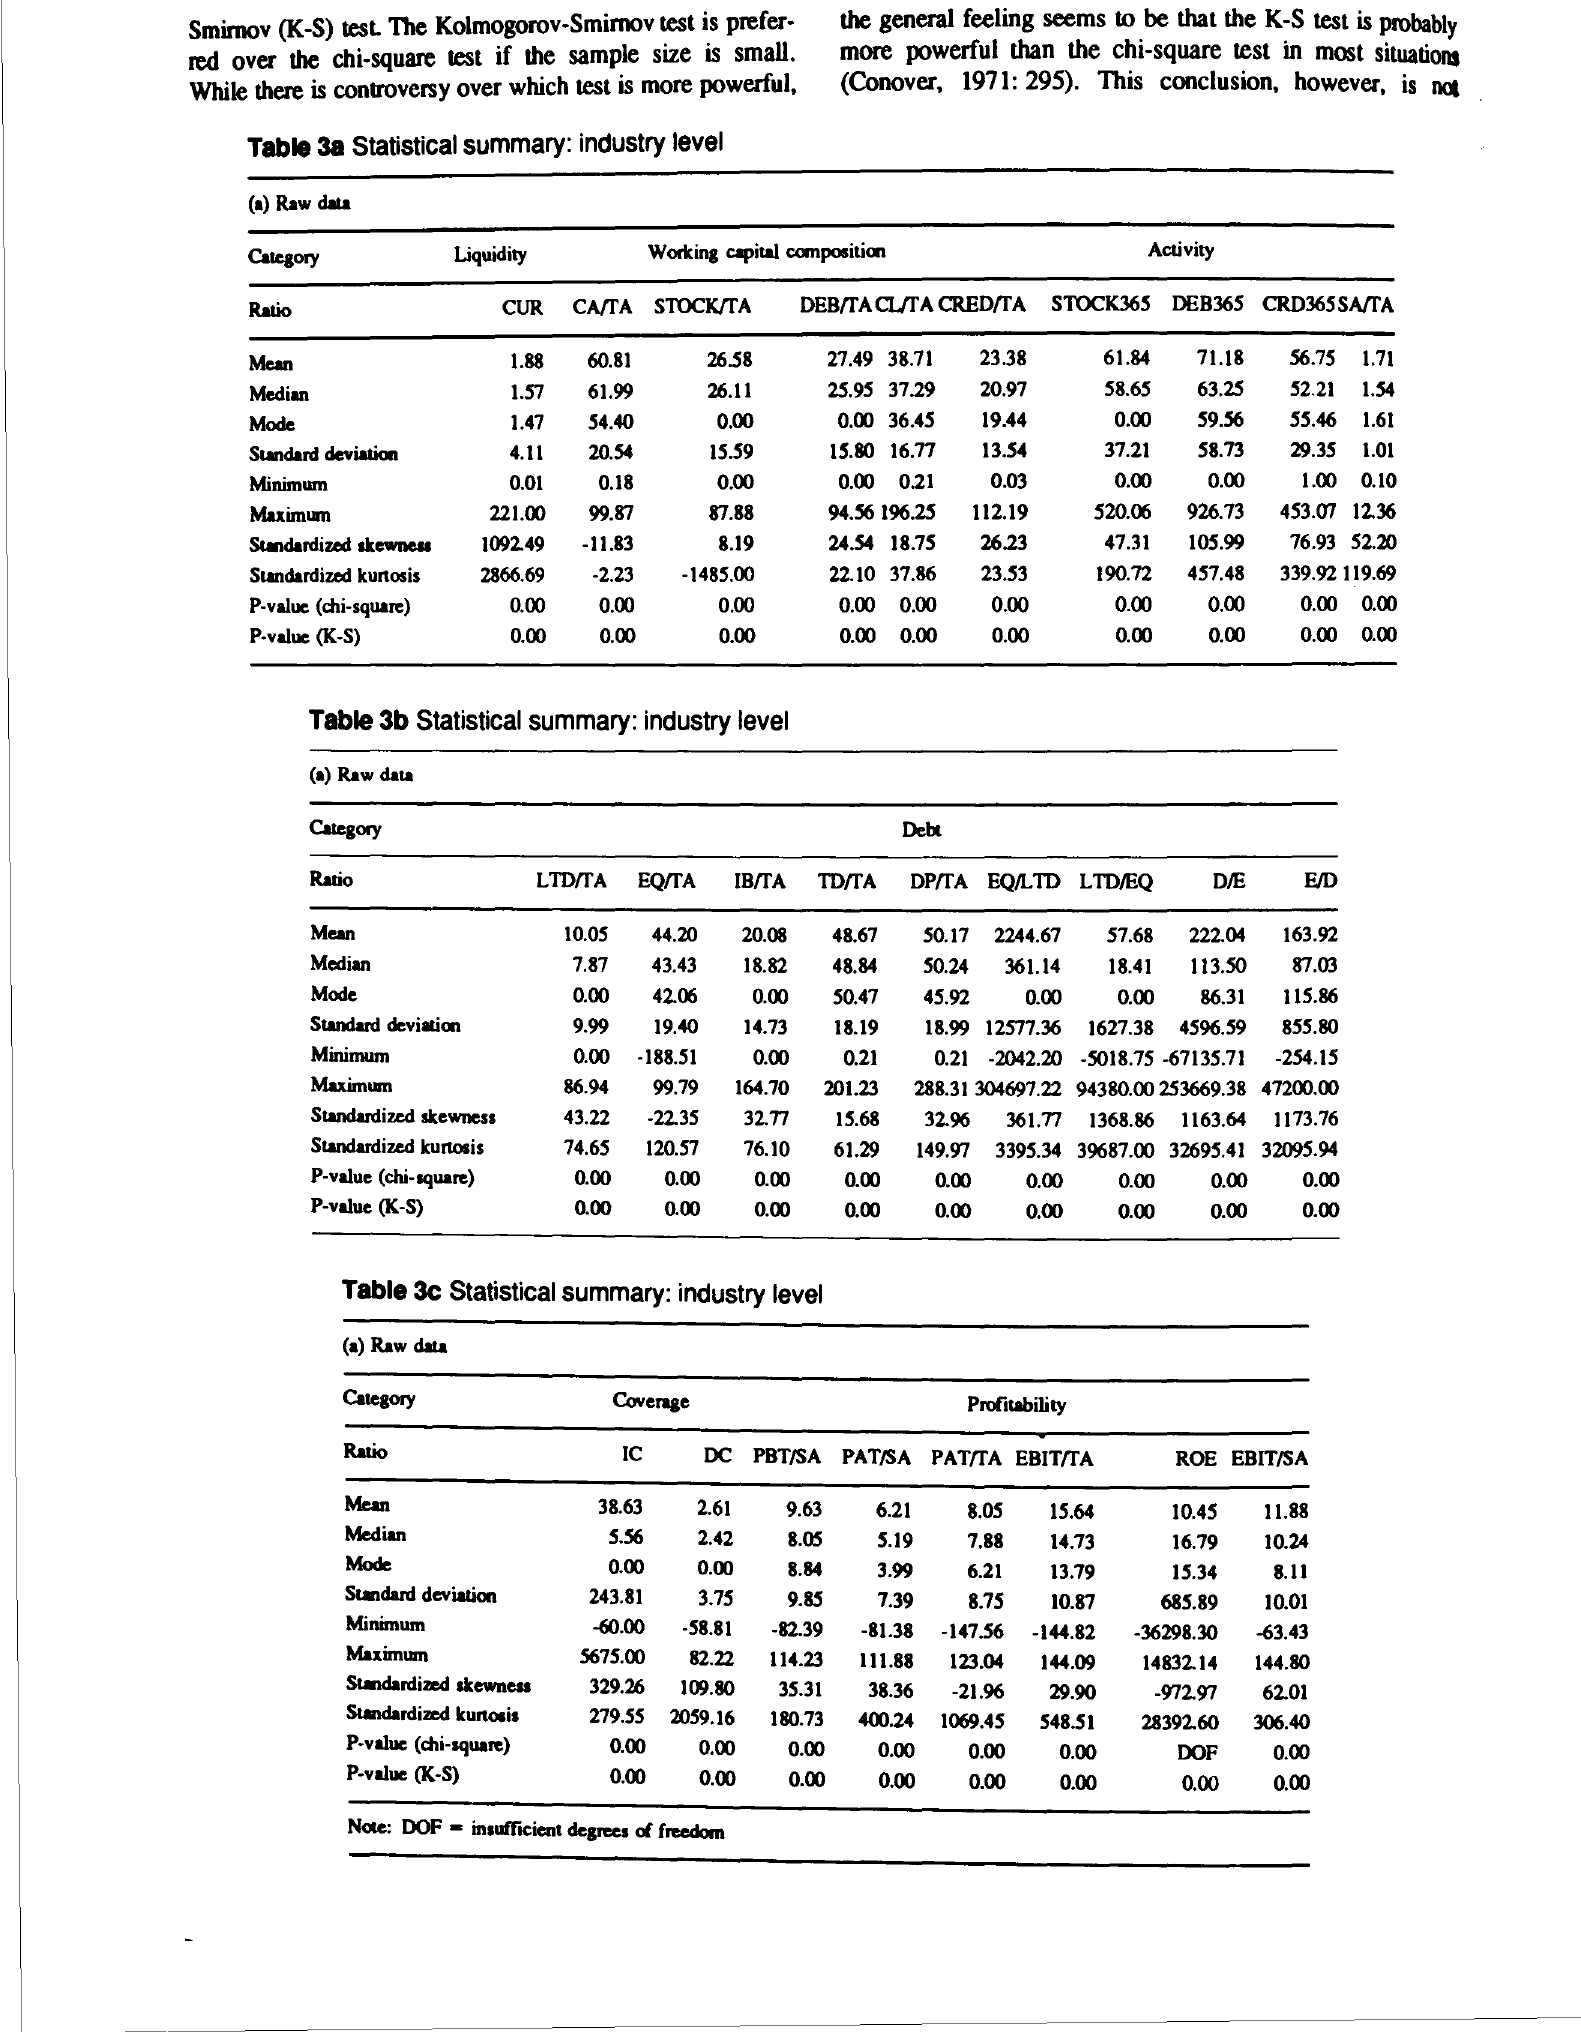
Table 3a Statistical summary: industry level